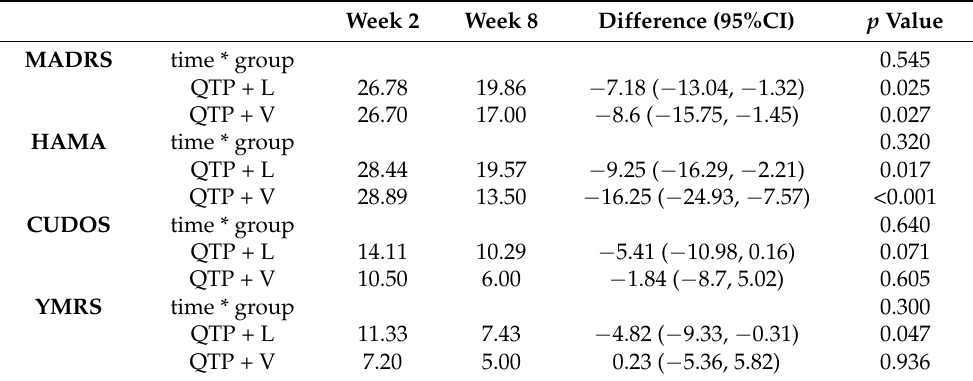
Table 3. Changes of MADRS, HAMA, CUDOS-M and YMRS scores in QTP + L and QTP + V group between week 2 and week 8 and interaction part of the model estimated by generalized mixed model # .